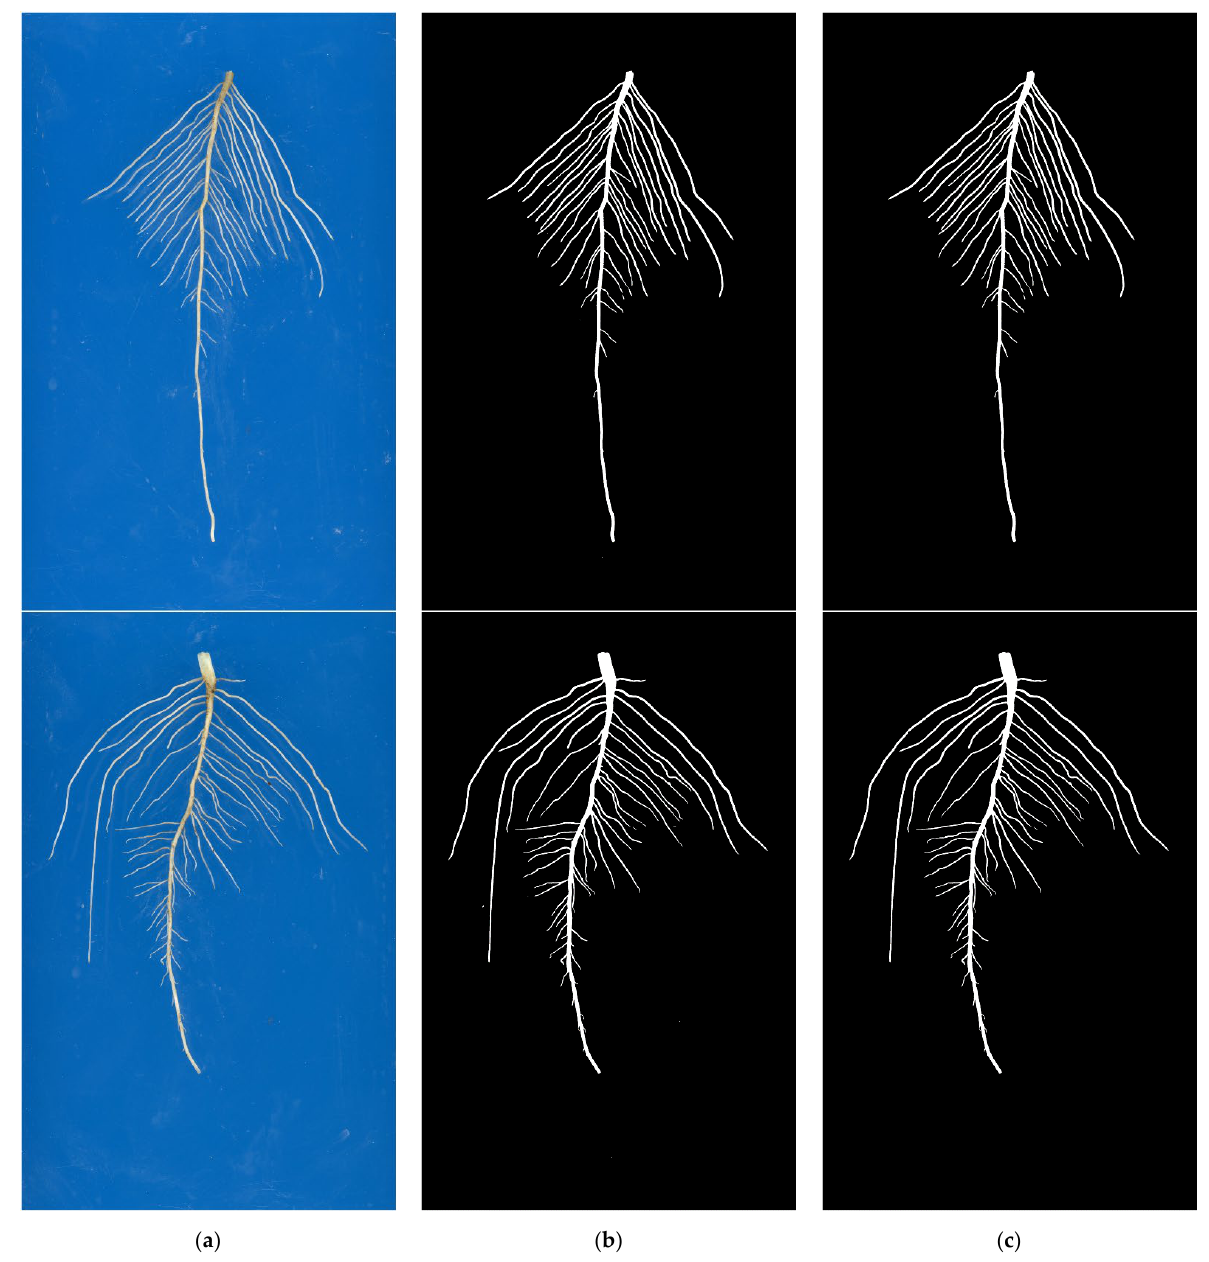
Figure 14. Image segmentation results of soybean seedling root system of multiple varieties under soil culture environment. ( a ) Original image; ( b ) Model prediction result; ( c ) Post-processing result.